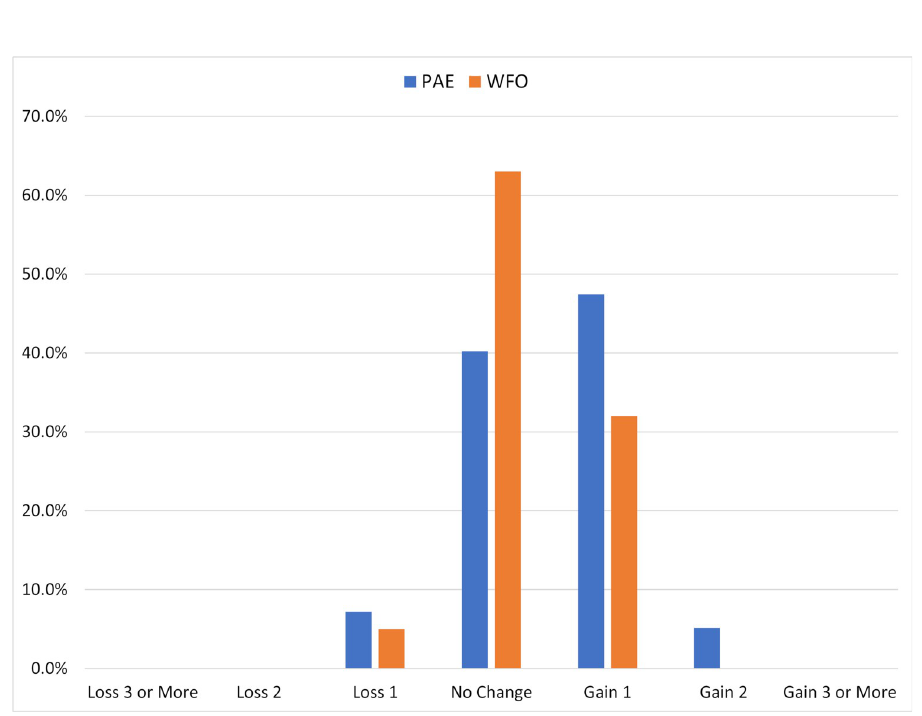
Fig 2. Preoperative to postoperative change in corrected distance visual acuity (CDVA). Abbreviations: WFO– wavefront optimized, PAE–Phorcides Analytic Engine.